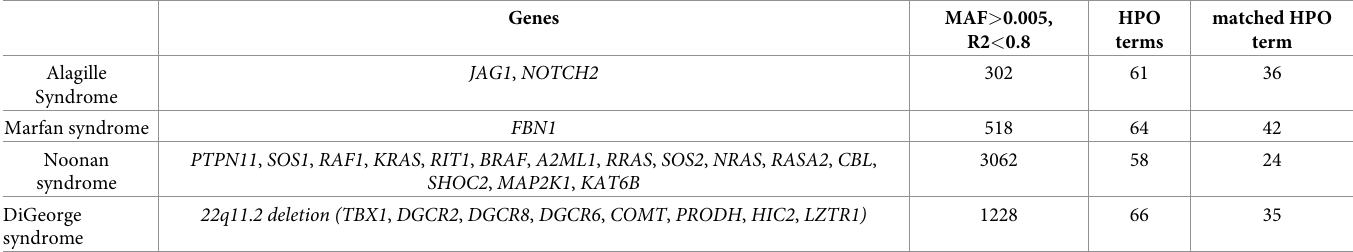
Table 3. Table summarizing number of genes, SNPs and phenotypes (HPO terms) for each syndrome included in our analysis. Genes MAF > 0.005, R2 <